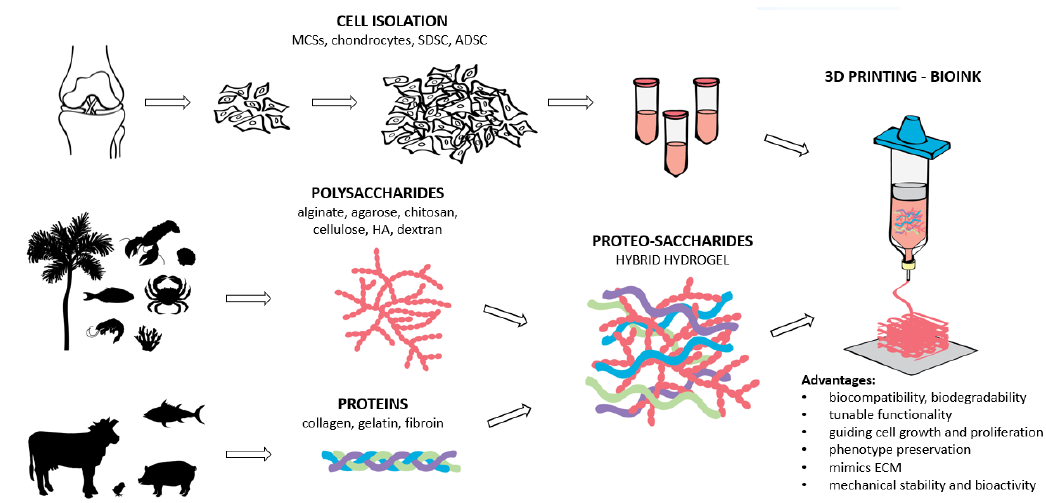
Figure 2. The schematic overview of the proteo-saccharides combination, their origin, and bioink preparation for hydrogel formation in CTE.